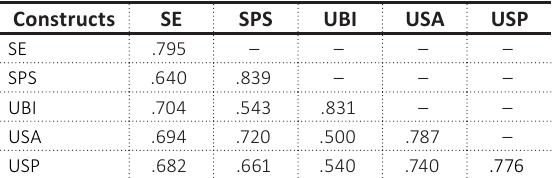
Table 2. Discriminant validity